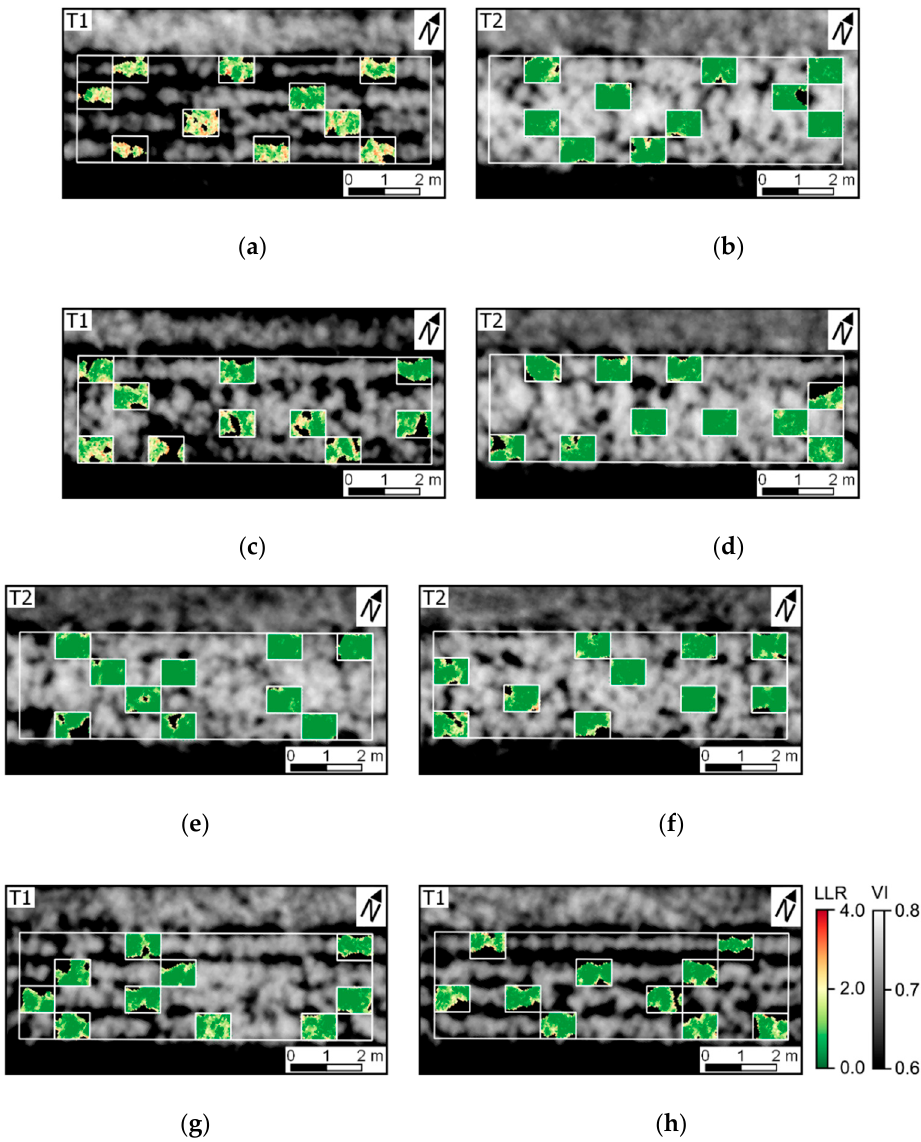
Figure 10. Log-likelihood ratio (LLR) for UAV data acquired 78 DAP (i.e., last data acquisition). LLR represents the comparison of pixel-wise probability considering distributions for diseased SUs (H1: ≤ 7.0% severity) and a healthy reference (H0: up to 1.0% late blight severity). OSAVI values are indicated in grey scale (VI). Experimental plots 1–8 are represented in figures ( a – h) . Table 2. Kendall-tau correlation coefficients between disease severity classes (as ordinal variable) and median of log-likelihood ratio (LLR as continuous variable) at sampling unit level for assessment made 64 and 78 DAP. Values are given for each disease severity class used to derive probability distributions, which were compared with the distribution for the reference class (only healthy patches for 64 DAP and ≤ 1.0% severity for 78 DAP) during estimation of pixel-wise LLR. Disease severity class considered for LLR calculation 64 DAP 2 78 DAP 2 Dataset ≤ 1.0 1